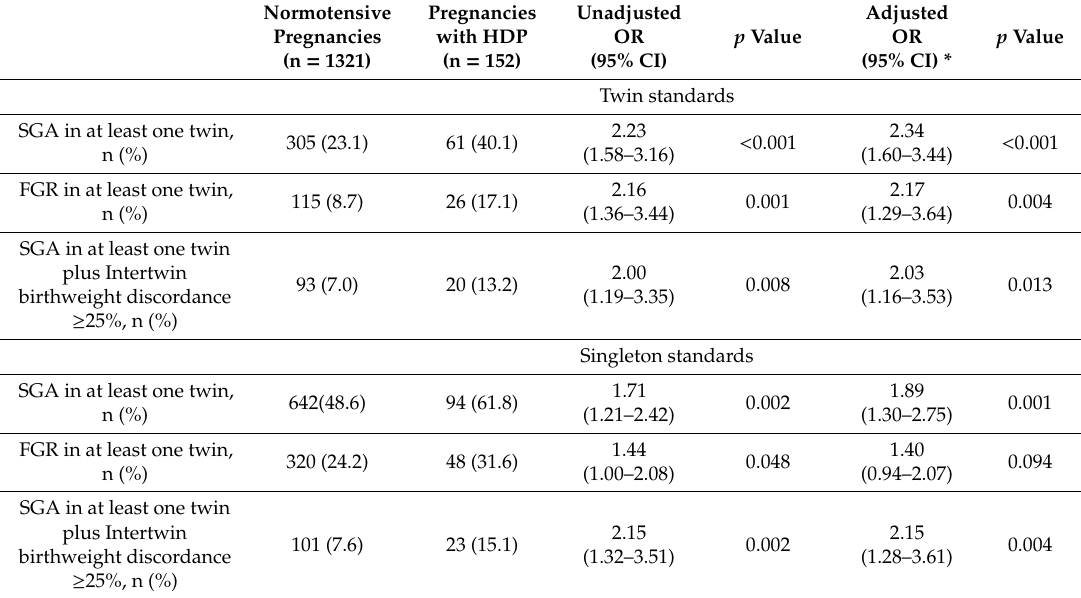
Table 3. The association between intertwin birthweight discordance, fetal growth restriction (FGR) and HDP.